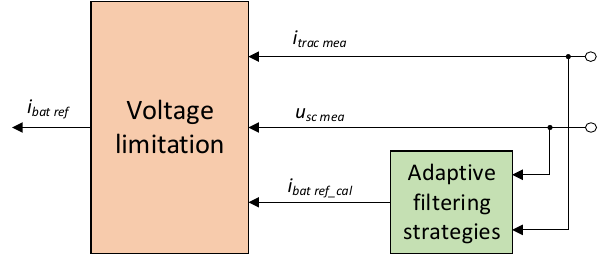
Figure 7. Implementation of the strategy